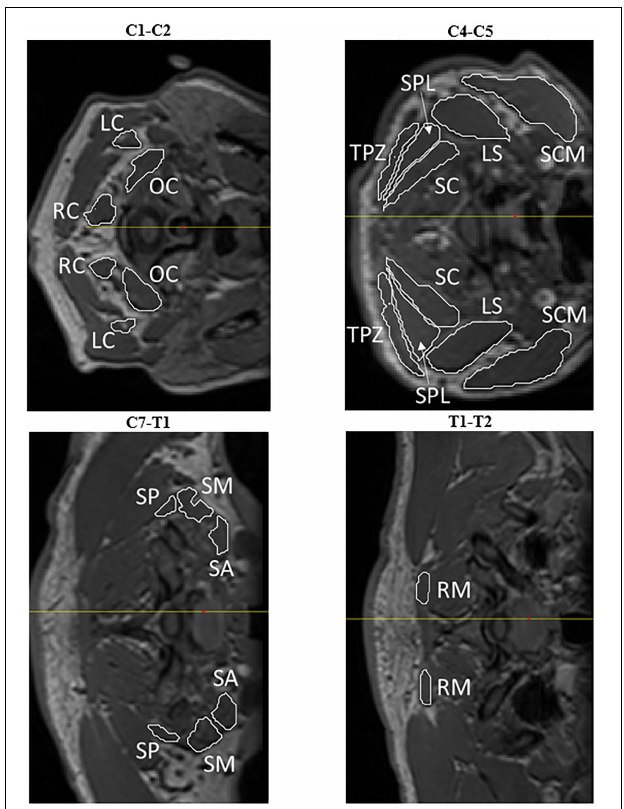
FIGURE 2 | Cross-sectional measurements were acquired at specific intervertebral levels for the longissimus capitis (LC), obliquus capitis inferior (OC), rectus capitis posterior major (RC), sternocleidomastoid (SCM), levator scapulae (LS), trapezius (TPZ), semispinalis capitis (SC), splenius (SPL), scalenus posterior (SP), scalenus medius (SM), scalenus anterior (SA), and rhomboid minor